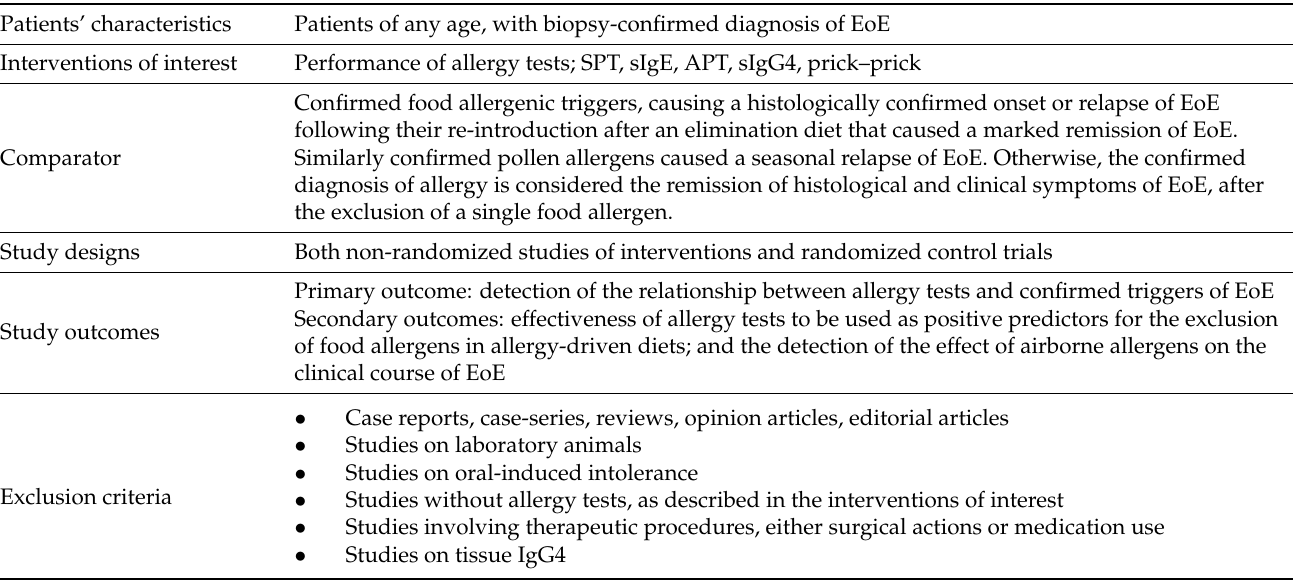
Table A1. Inclusion and exclusion